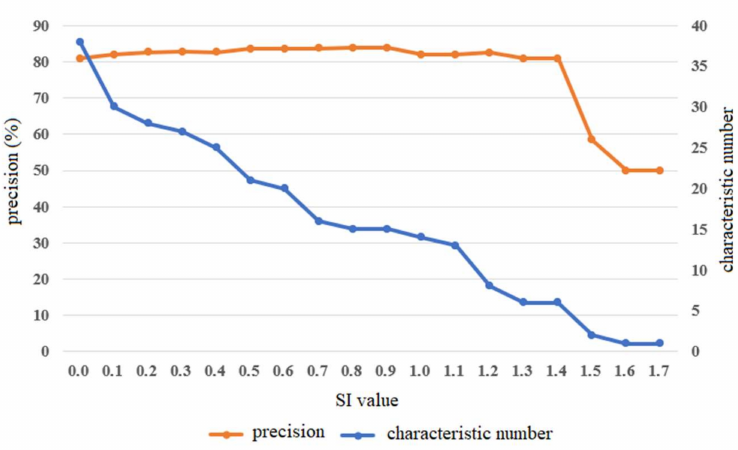
Figure 5. Characteristic number and precision corresponding to different SI